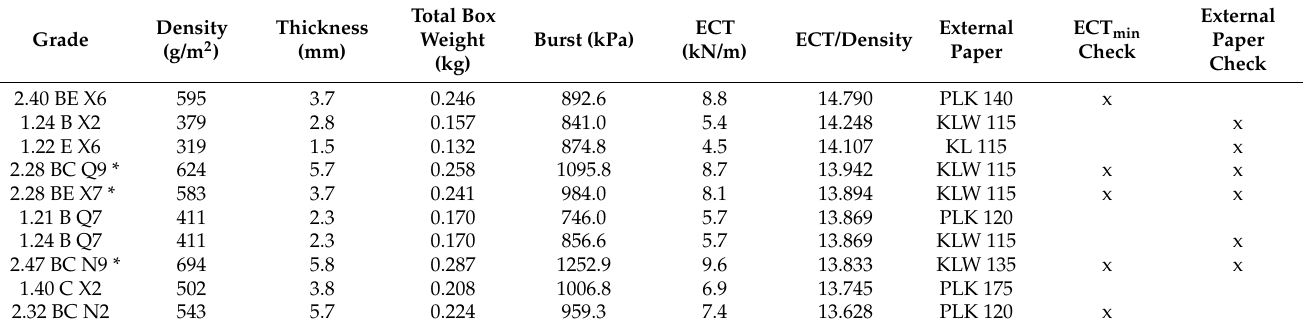
Table 2. Extract of the analyzed grades: top ten grades according to ECT/Density ratio. The total box weight was computed based on a sample area of 0.4134 m 2 . The first three columns list geometry- related values, and the results of the Burst test and ECT are reported. The final columns report whether (x) or not the checked condition is met.